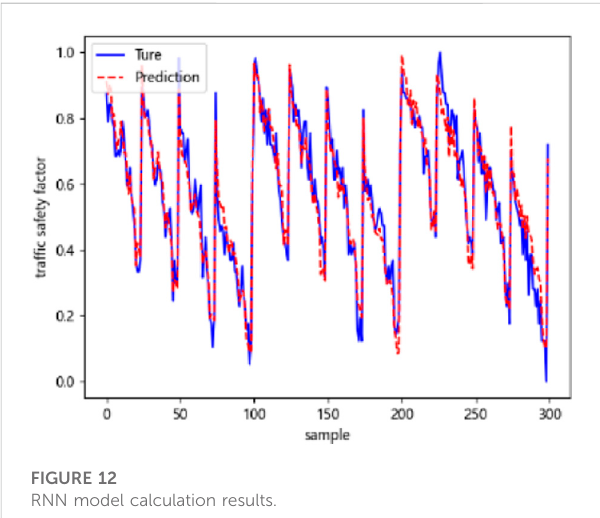
FIGURE 10 Data prediction results.